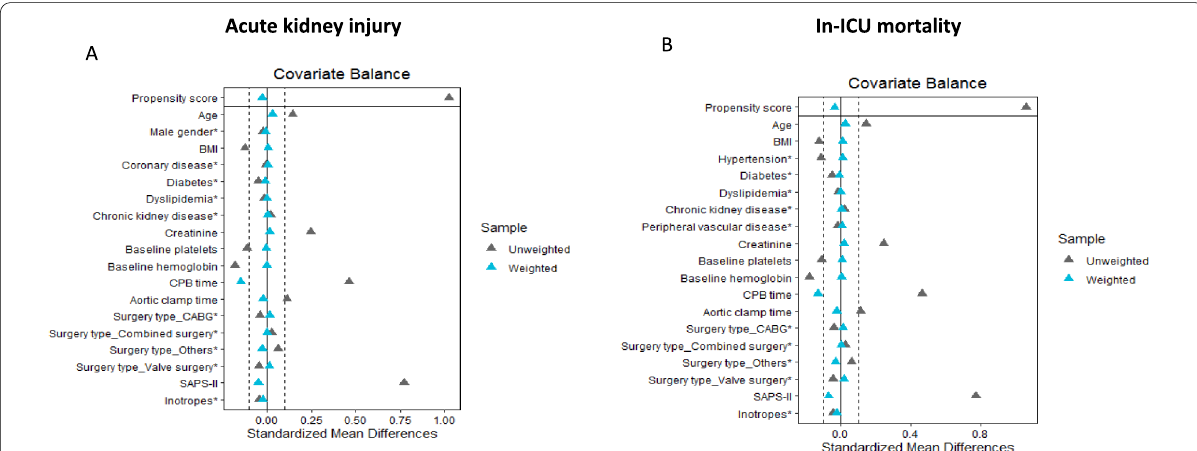
Fig. 2 Love plots for standardized mean differences comparing covariate values before (grey triangle) and after (blue triangle) propensity score weighting for the assessment of acute kidney injury ( A ) and in‑ICU mortality ( B ). Standardized mean differences are expressed as percentages. An absolute MSD < 15% was considered to support the assumption of balance between the groups. BMI: body‑mass index, CABG: coronary bypass graft, CPB: cardiopulmonary bypass, SAPS II: Simplified Acute Physiology Score. *: inotropes include the use of dobutamine or epinephrine associated or not to